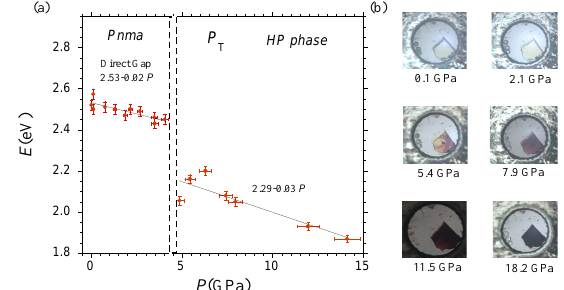
Figure 3: (a) Variation of the charge-transfer band gap with pressure in both Pnma phase and high-pressure phase. The direct gap shifts toward lower energies with pressure. (b) Images of a single crystal of Cs 2 CuCl 4 in a DAC at different pressures. Note how the crystal varies from yellow to dark red and eventually to black upon increasing pressure. The piezochromism is associ- ated with the redshifted charge-transfer band gap with pressure. Single crystal dimensions (ambient pressure): 80 × 80 × 22 µ m 3